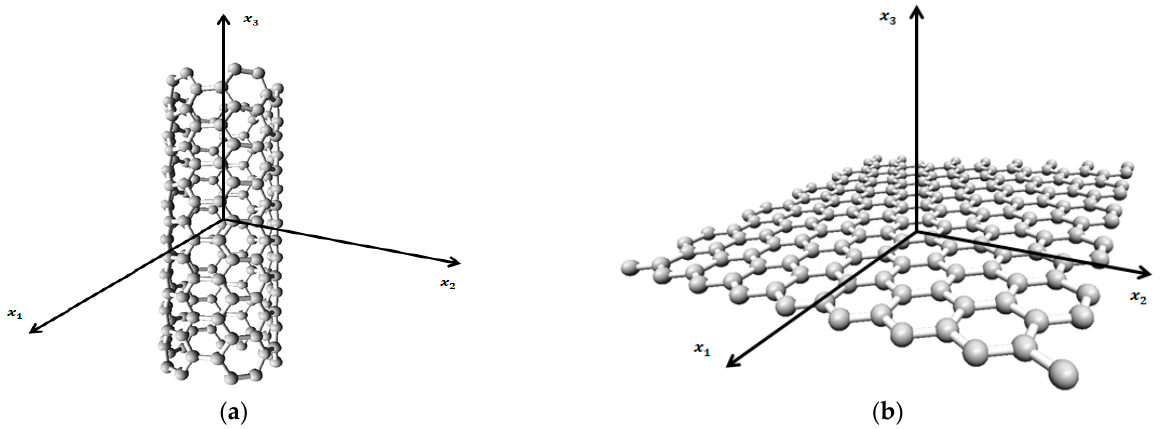
Figure 2. Coordinate system carbon nanotubes CNT ( a ) and graphene nanoplatelets GNP ( b ).